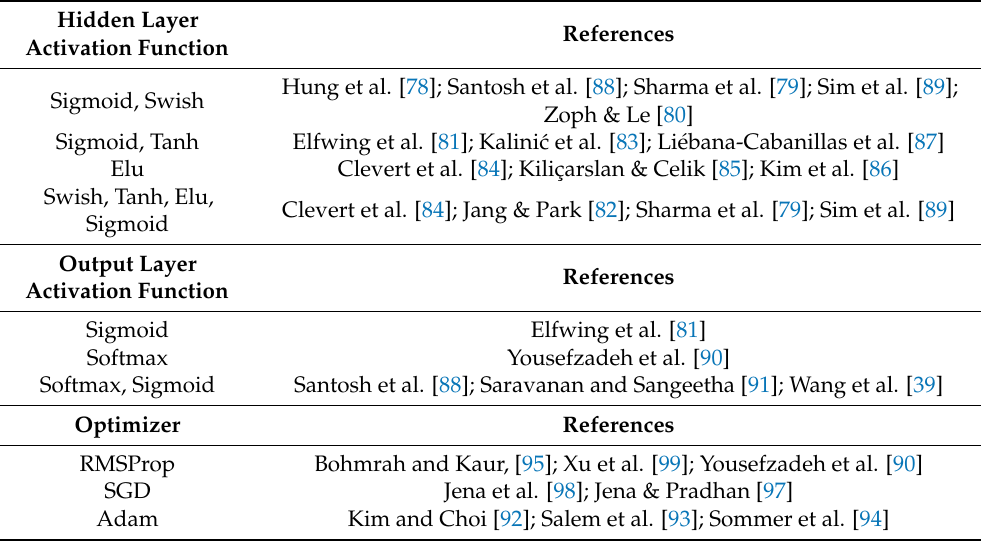
Table 3. Activation function and